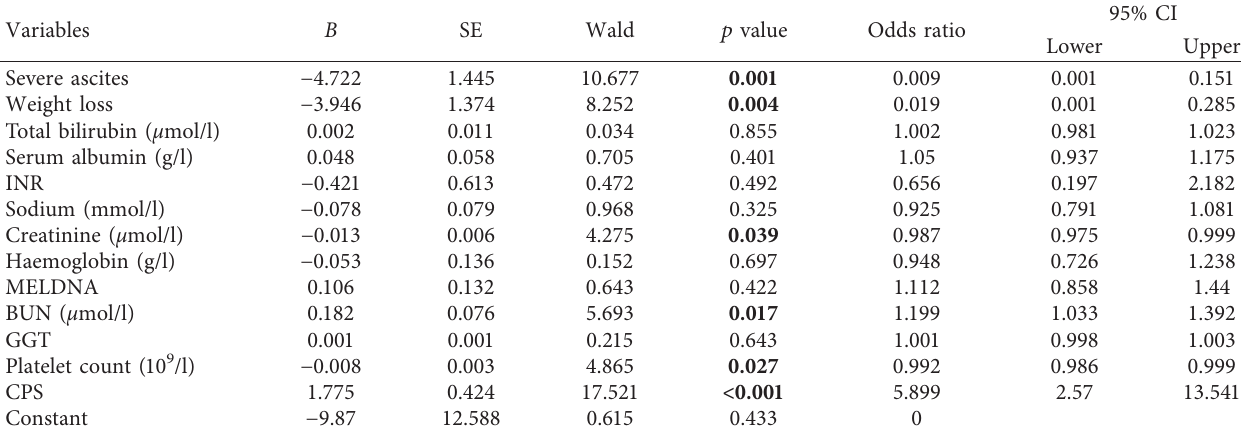
Table 7: Logistic regression of independent variables associated with